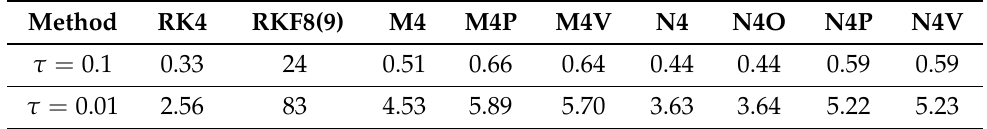
Table 3. CPU times (unit: Second) of each algorithm in Figure